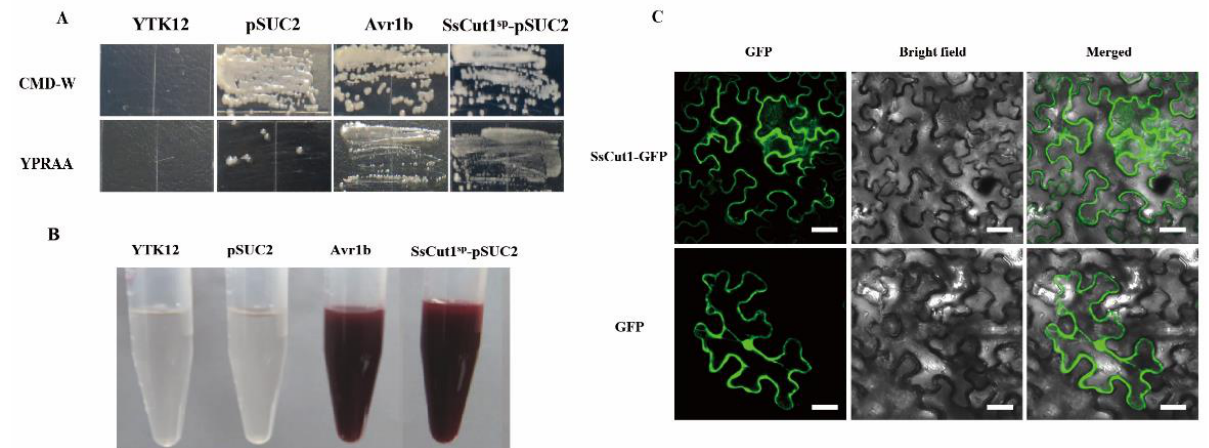
Figure 3. SsCut1 has a functional signal peptide and is localized in the plant cell wall. ( A ) Validation of the secretion function of the SsCut1 signal peptide by the yeast secretion trap screen assay. Signal peptide of SsCut1 was fused in frame to the yeast invertase sequence in pSUC2 vector and expressed in YTK12 strains. The functional signal peptide of Avr1b was used as a positive control, while the YTK12 and pSUC2 empty plasmid was used as a negative control. ( B ) The invertase activity in TTC medium. TTC encounters raffinose breakdown products to produce triphenylformazan, which shows a red reaction to confirm that a functional signal peptide can cause sucrose invertase to be secreted. ( C ) Subcellular localization of SsCut1 in N. benthamiana epidermal cells. SsCut1-GFP localized in the plant cell wall. The fluorescence of GFP was monitored at 2 d post-agroinfiltration using confocal laser scanning microscopy. Bar = 20 µm.